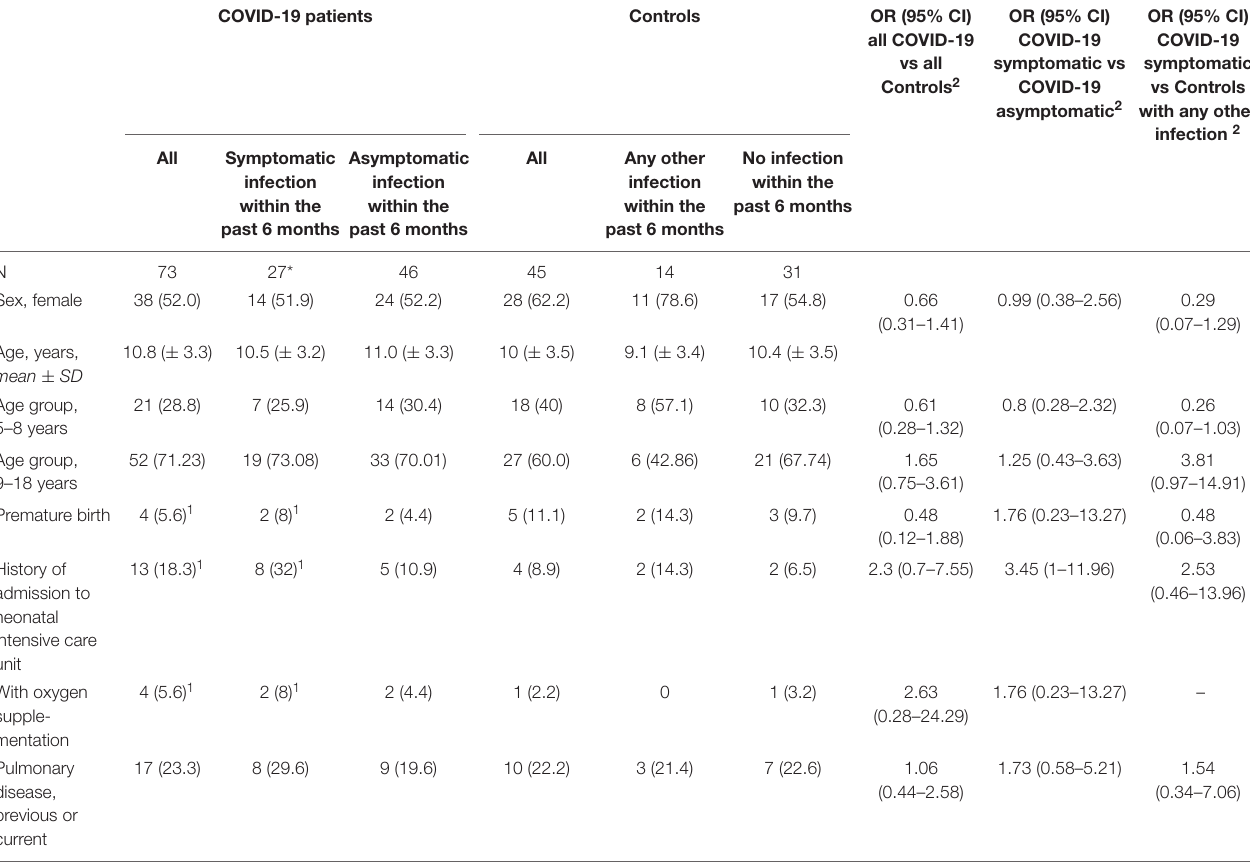
TABLE 1 | Epidemiological